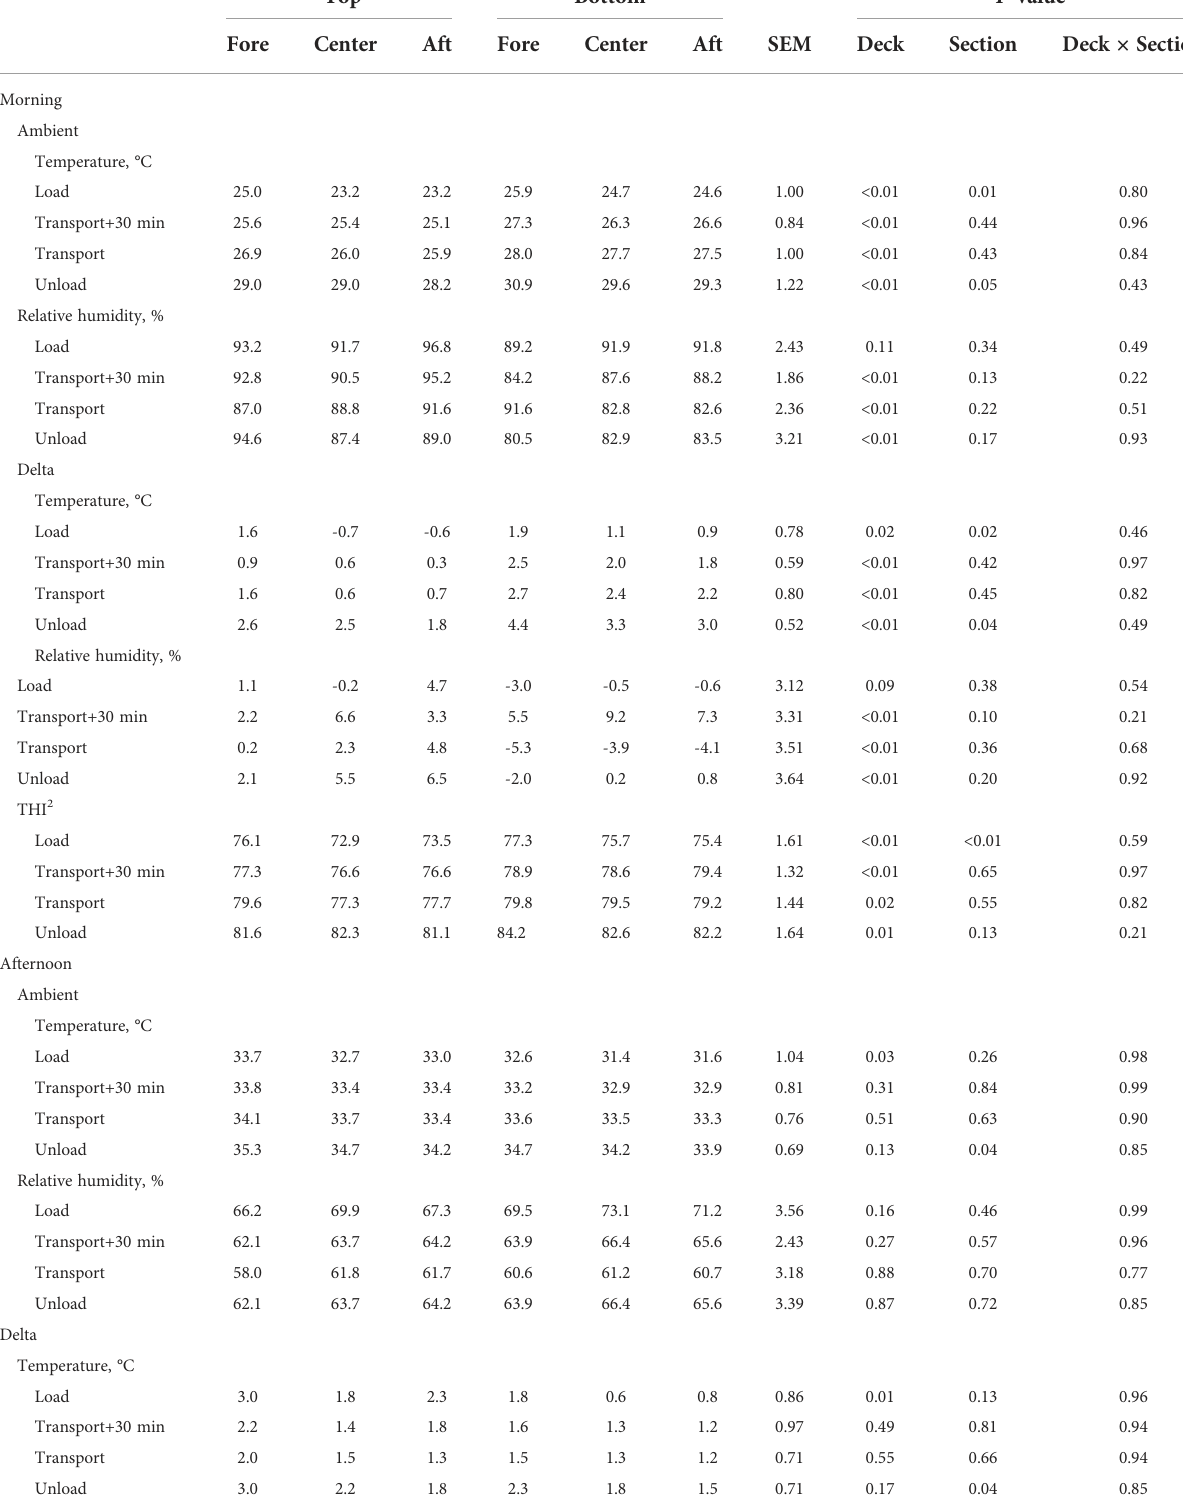
TABLE 2 Avrage ambient and delta-temperature and relative humidity by deck of straight-deck trailers transporting market pigs in North Carolina during August 2021 1 . Top Bottom P -value Fore Center Aft Fore Center Aft SEM Deck Section Deck ×